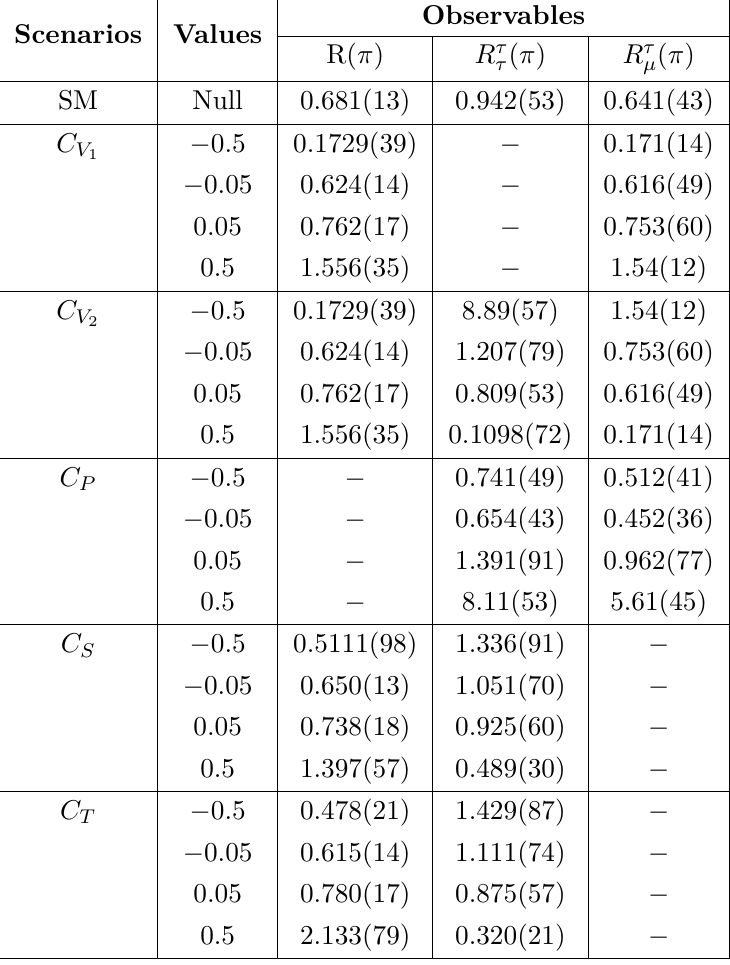
Table 11. NP predictions at differnt values for the corresponding Wilson coefficients (taken one at a time) corresponding to the B → π